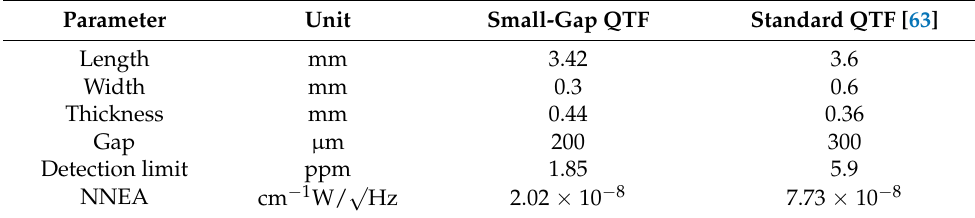
Table 2. Dimensions and parameters of two